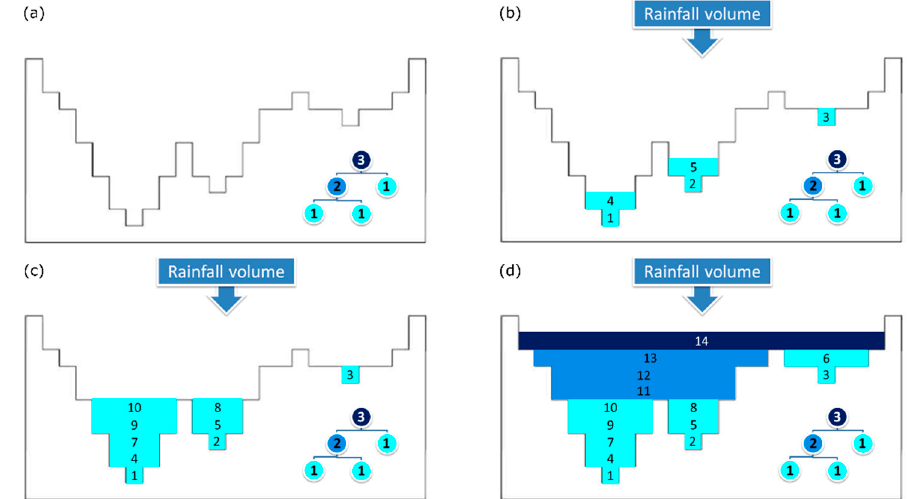
Figure 3. Schematic representation of the hierarchical structure of nested depressions. ( a ) Plan view of the intermediate-level depressions, each one associated with a specific color and identification code (ID, from 1 to 15). ( b ) Cross-sectional view A-A of the depressions 3, 5, 7, 8 identified in panel ( a ). ( c ) Hierarchical tree of the nested depression systems: intermediate-level depressions are represented with circles (see ID and color in panel ( a )); the corresponding hierarchy level of filling for the bottom-up flooding phase is indicated with numbers from 1 to 3 (2.01, 2.02, 2.03 indicate intermediate levels).